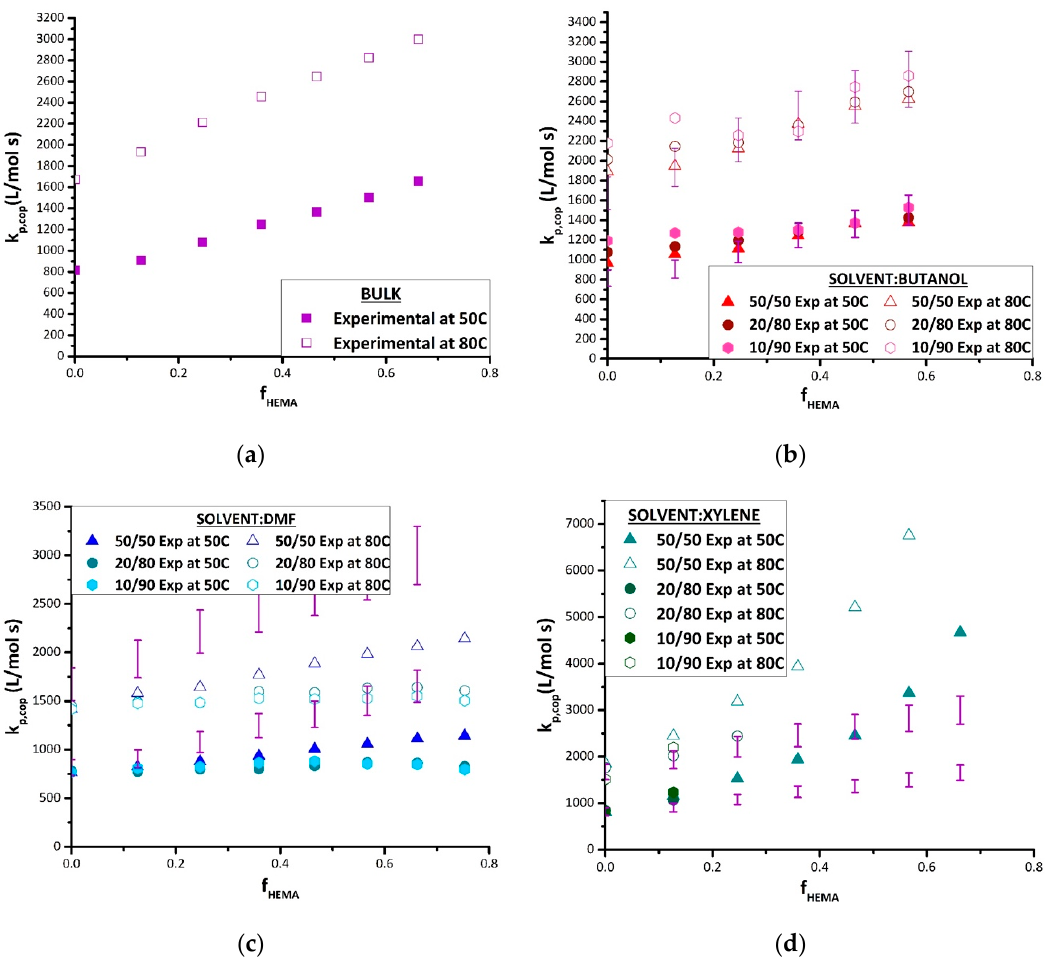
Figure 5. Copolymer k p,cop values plotted against HEMA molar fraction in the BMA/HEMA monomer mixture (f HEMA ) as measured by PLP/SEC at 50 and 80 °C at different monomer/solvent volume ratios (see legends) in ( a ) bulk, ( b ) n -butanol, ( c ) dimethylformamide, and ( d ) xylenes. The results obtained in bulk are included in the plots for solvents with 10% error bars.